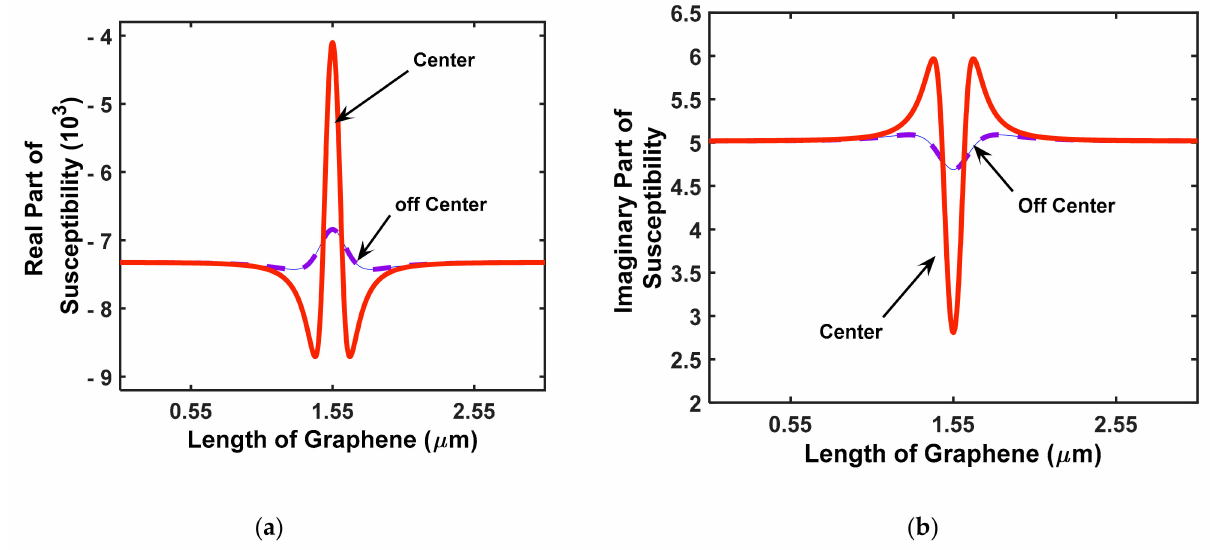
Figure 9. The ( a ) real and ( b ) imaginary parts of susceptibility for two different modes of quantum dot ( r QD = 100 ( nm ) , ε b = 12 ) .